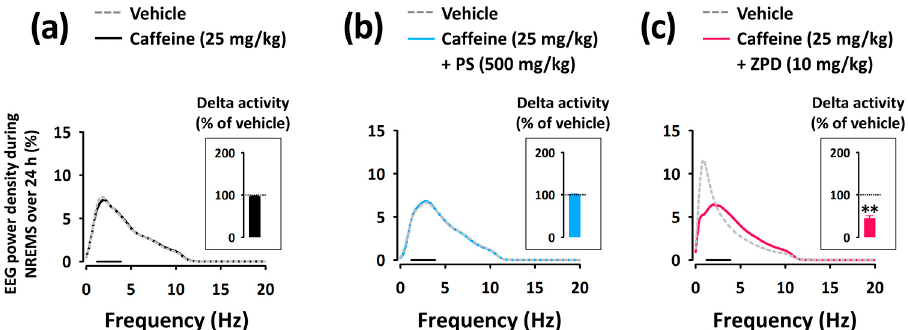
Figure 5. EEG power density curves during NREMS caused by caffeine alone ( a ) and co-administration of PS ( b ) or ZPD ( c ) with caffeine. Delta activity, an index of sleep intensity, is shown in the inset histogram. The solid bar ( — ) represents the range of the delta wave (0.5-4 Hz). ** p < 0.01, significantly different from the vehicle control (unpaired Student’s t -test). EEG, electroencephalogram; NREMS, non-rapid eye movement sleep; PS, a standardized phlorotannin supplement; ZPD,